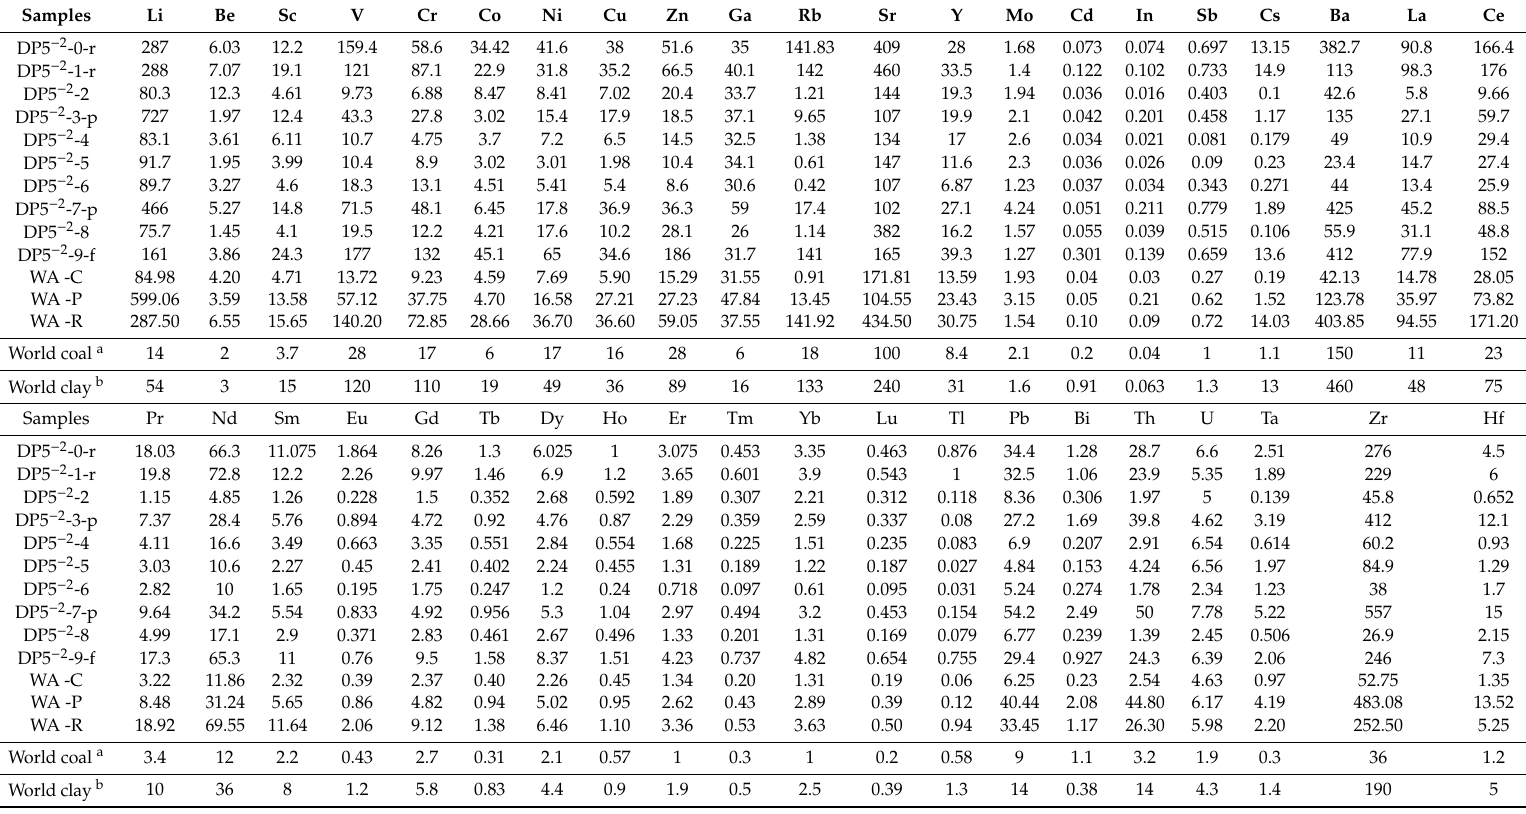
Table 5. Trace element concentrations ( µ g / g) of the Dongpo coals, partings, and host rocks.